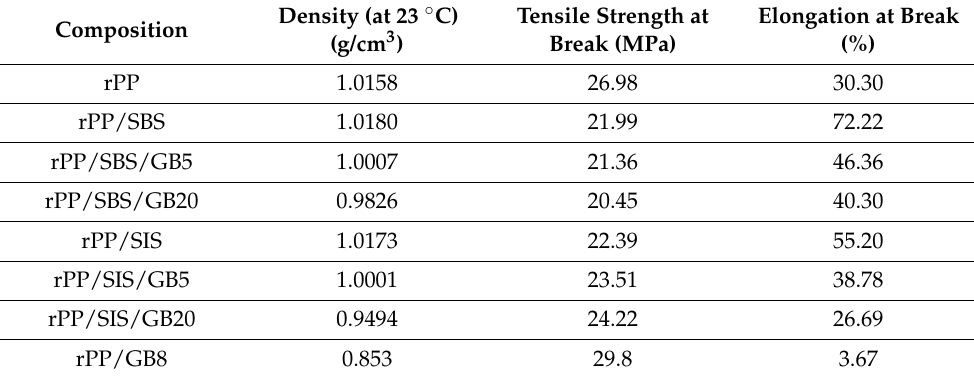
Table 2. Mechanical test results for recycled polypropylene reinforced with glass bubbles